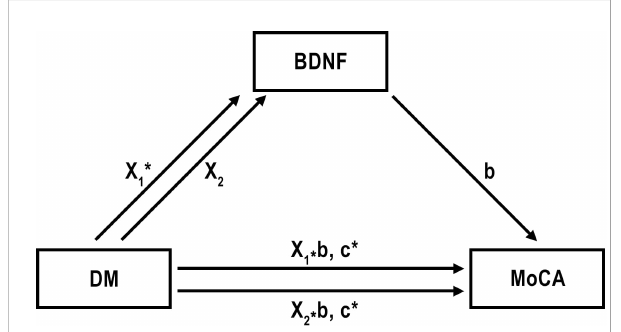
FIGURE 2 Effect of diabetes and prediabetes on MoCA through BDNF. X 1 = Effect of T2DM on BDNF; X 2 = Effect of preDM on BDNF; b= Effect of BDNF on MoCA; X 1* b and X 2* b are indirect effects of DM and PreDM on MoCA. c= direct effect of DM on MoCA. *p ≤ 0.01.